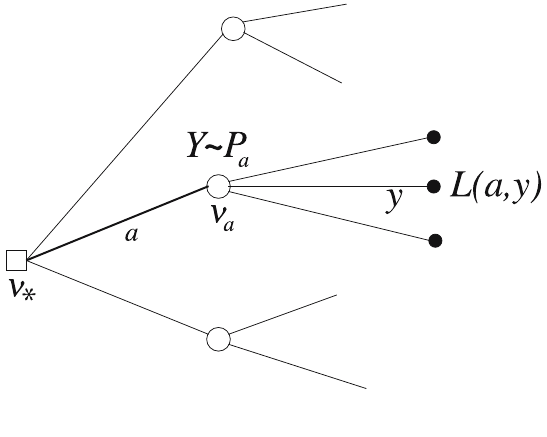
Figure 3: Decision